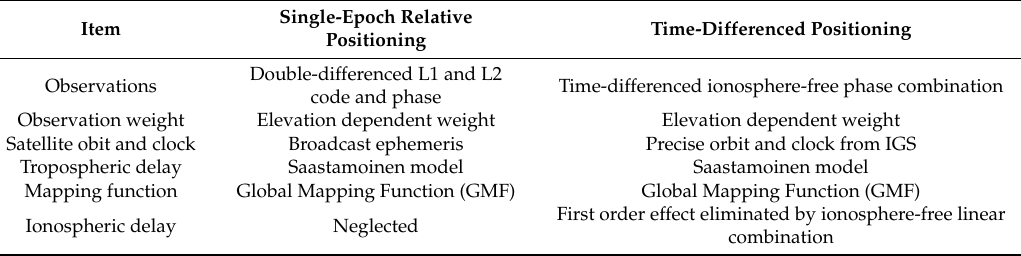
Table 1. Data processing strategies.